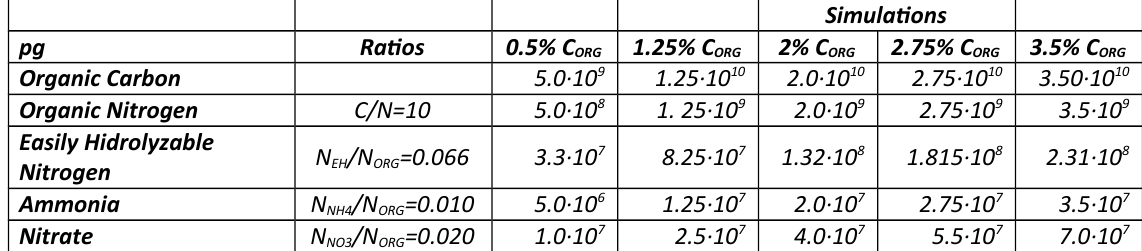
Table 2. Input soil data for running the